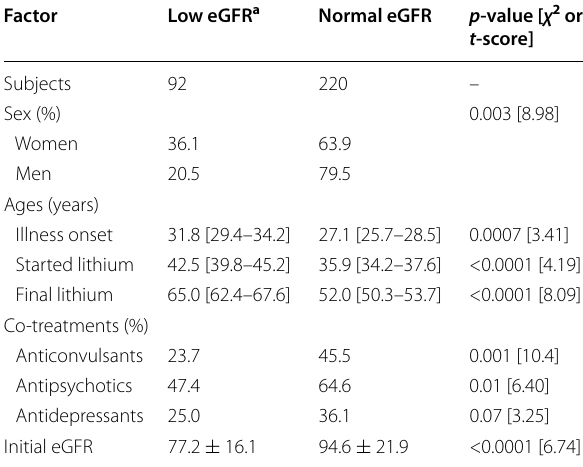
Table 4 Factors associated with vs. without low eGFR among 312 bipolar disorder subjects treated long-term with lithium